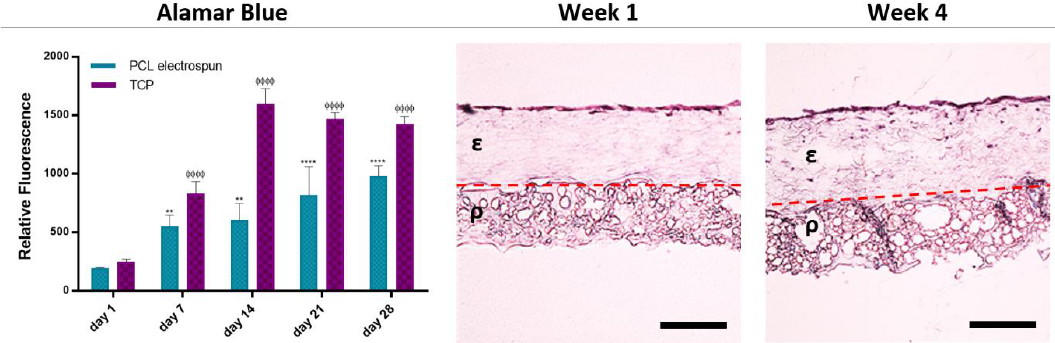
Figure 9. Evaluation of the biocompatibility and the barrier properties of the bilayer BM. The metabolic activity of the HDFs growing on PCL electrospun layer from day 1 to day 28 is given in the graph (*** and ΦΦΦ p ≤ 0.001, ** and ΦΦ p ≤ 0.01, * and Φ p ≤ 0.05, n = 3). Histological images demonstrate the barrier properties of the PCL electrospun layer over 4 weeks. ε and ρ indicate the electrospun layer and PCL polyHIPE layer, respectively. Dotted line indicates the boundary of the two layers (Scale bar represents 200 µm).